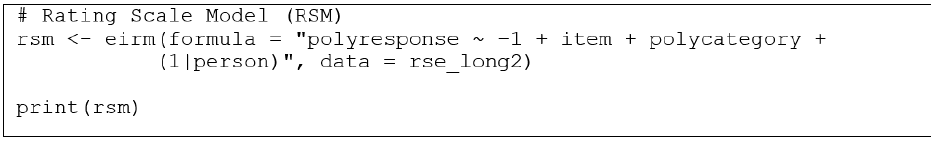
Figure 13. Estimate the Rating Scale Model and print the model output.